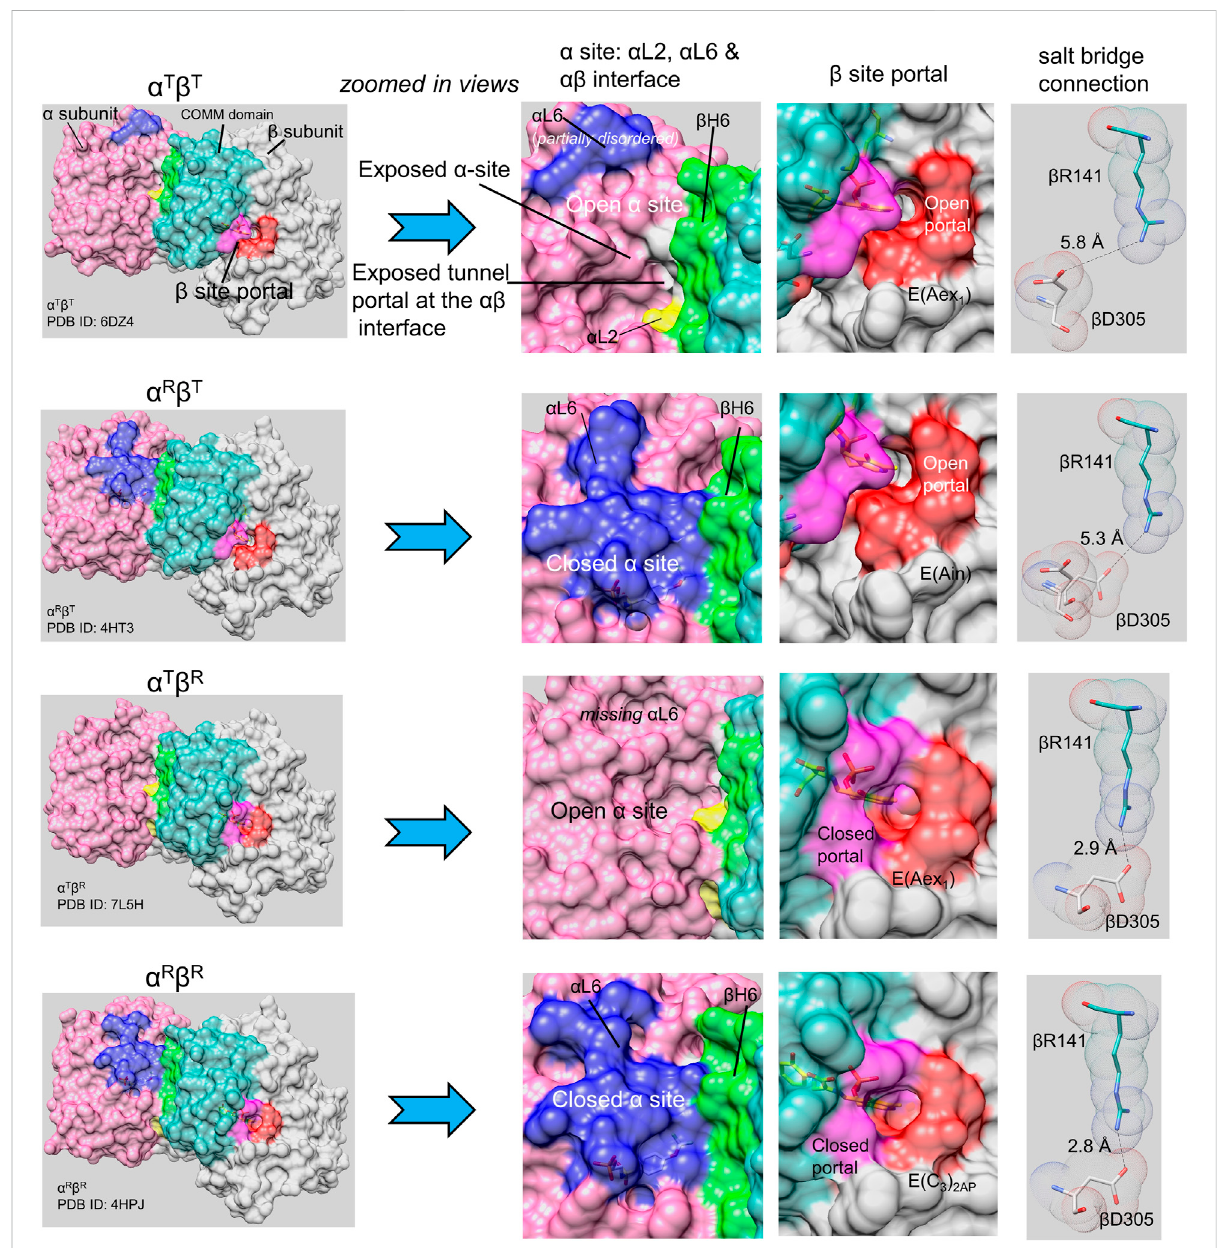
FIGURE 2 The TS allostery model consists of two subunit conformations, T and R, and four quaternary states, α T β T , α R β T , α T β R and α R β R (Niks et al., 2013). Surface models are shown for the four quaternary states (left column) for each heterodimeric unit. The left column provides an overview of each quaternary state: each panel shows the α -subunit in light purple with loop α L2 (residues 53 – 60) yellow, loop α L6 (residues 179 – 193) blue; the β - subunitisshowningraywiththeCOMMdomain(residues102 – 189)inlightblue-greenandhelix β H6ingreen.The β -siteportalisshownindark purple(COMMdomainresidues)andorange.Thecentraltwocolumnsshowexpandedviewsofthe α -and β -subunitsfocusingonthecatalyticsites, the α - β subunit interface, and with the portals into the interconnecting tunnel. Ligands bound to the α - and β -sites are shown as sticks. The last column shows structural detail for β Arg141 and β Asp305 in each quaternary state; when the β -subunit is closed, these residues form an H-bonded salt bridge. Notice that the loop α L6 residues are either partially missing or completely missing in the α T conformation, and that the β -subunit portal switches between open and closed states depending on whether the β -subunit is in the β T or β R conformation. Images rendered in PyMol (Schrodinger,